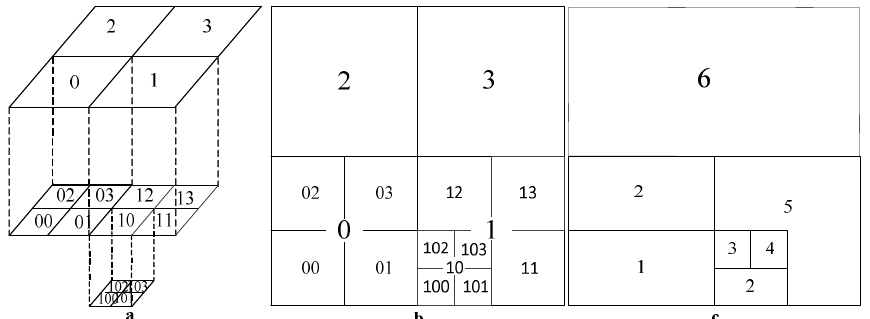
Figure 7. Z-curve hierarchy principle. ( a ) Three dimensional representation of spatial region divided by Z-curve, ( b ) Two dimensional representation of spatial region divided by Z-curve, ( c ) Two dimensional representation of merged spatial regions.